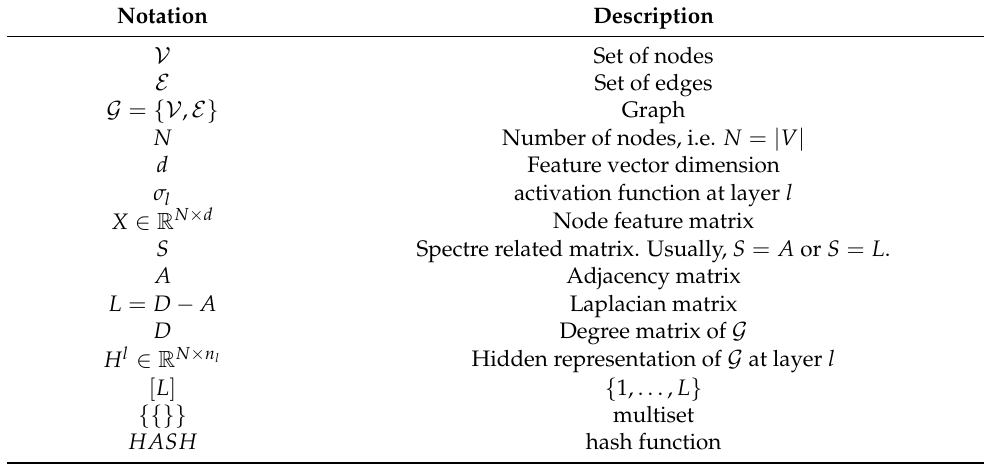
Table 1. Notations used in the